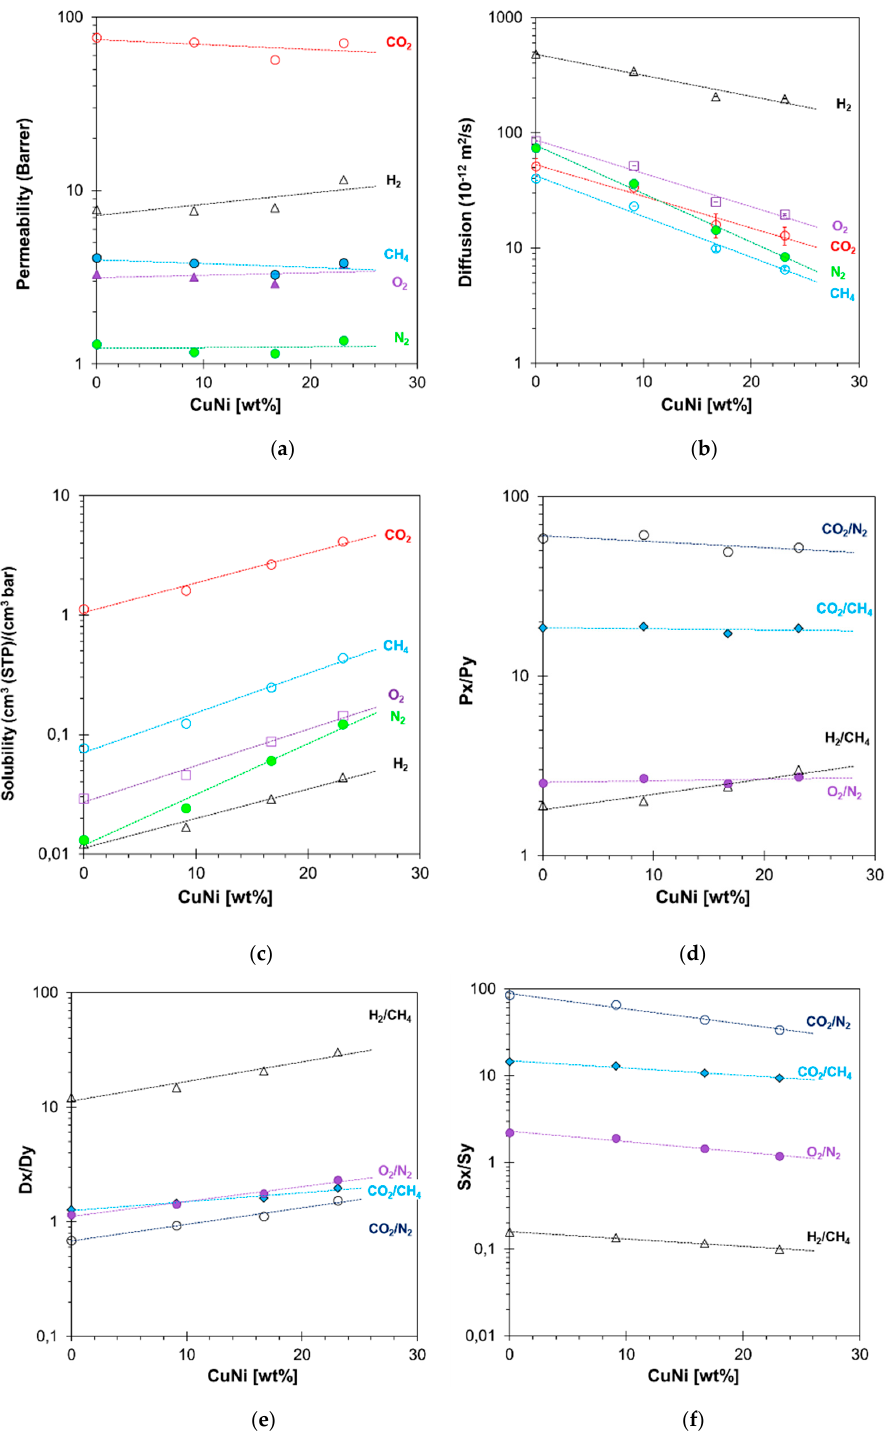
Figure 5. ( a ) Permeability, ( b ) diffusivity, and ( c ) solubility coefficients, and their respective selectivity towards N 2 ( d , e , f ) for each gas as functions of the weight percentage of CuNi-MOF in Pebax ® 1657. In contrast to the effect in Pebax ® 1657, CuNi-MOF causes a drastic increase in the gas permeability for all gases as function of MOFs loading in the glassy PEEK-WC, and the order of permeation obeys that of the diffusion-controlled gas transport mechanism with H 2 > CO 2 > O 2 > N 2 > CH 4 , typical for glassy polymers (Figure 6a). The increase in permeability is a direct consequence